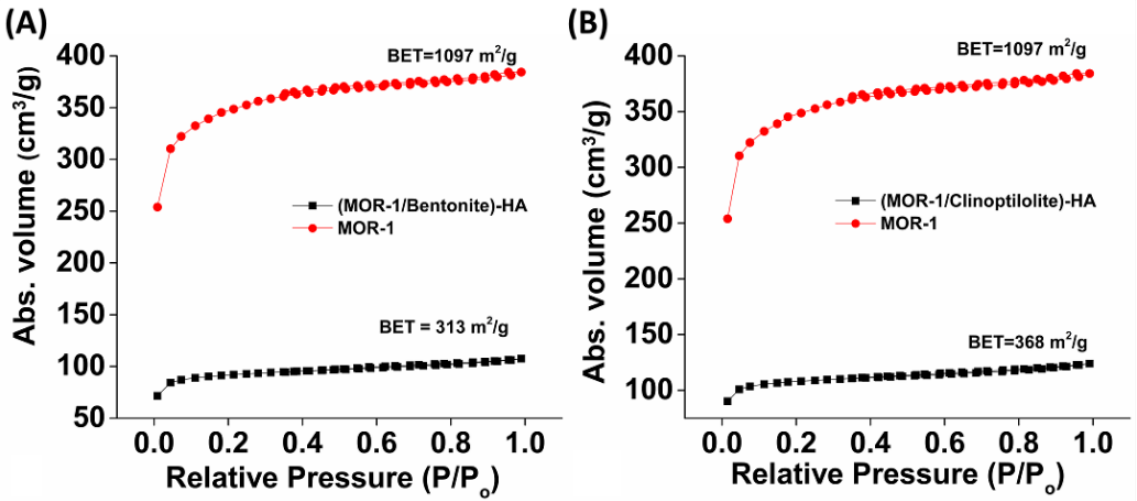
Figure 5. N 2 sorption isotherms (77 K) for MOR-1, ( A ) (MOR-1/Bentonite)-HA , and ( B ) (MOR- 1/Clinoptilolite)-HA .